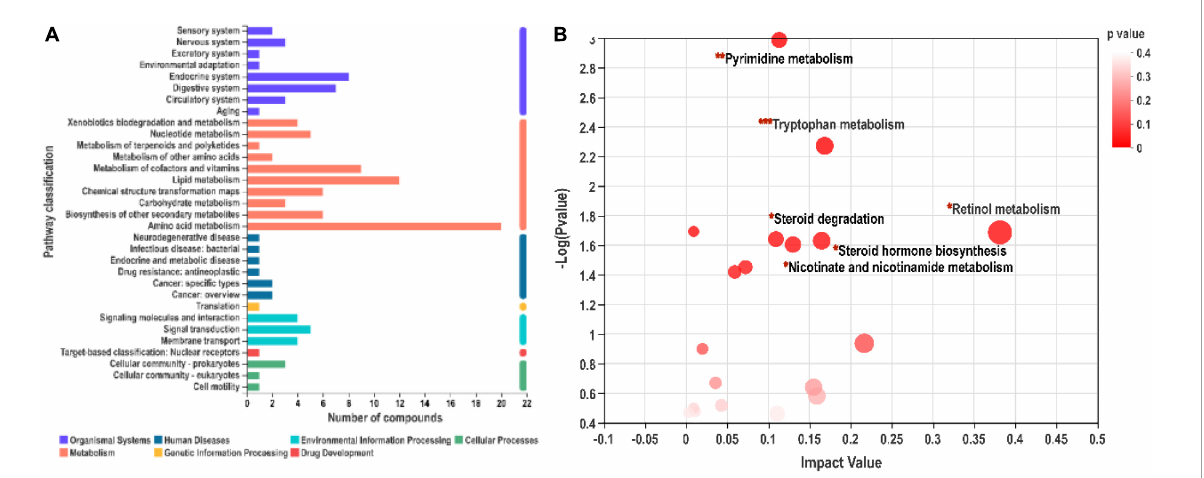
FIGURE6 Kyoto encyclopedia of genes and genomes (KEGG) functional pathway annotation (A) and enrichment (B) analysis. (A) The ordinate represents the secondary classification items of the KEGG pathway, and the abscissa represents the number of metabolites annotated to the pathway. (B) Pathway enrichment analysis of differentially expressed